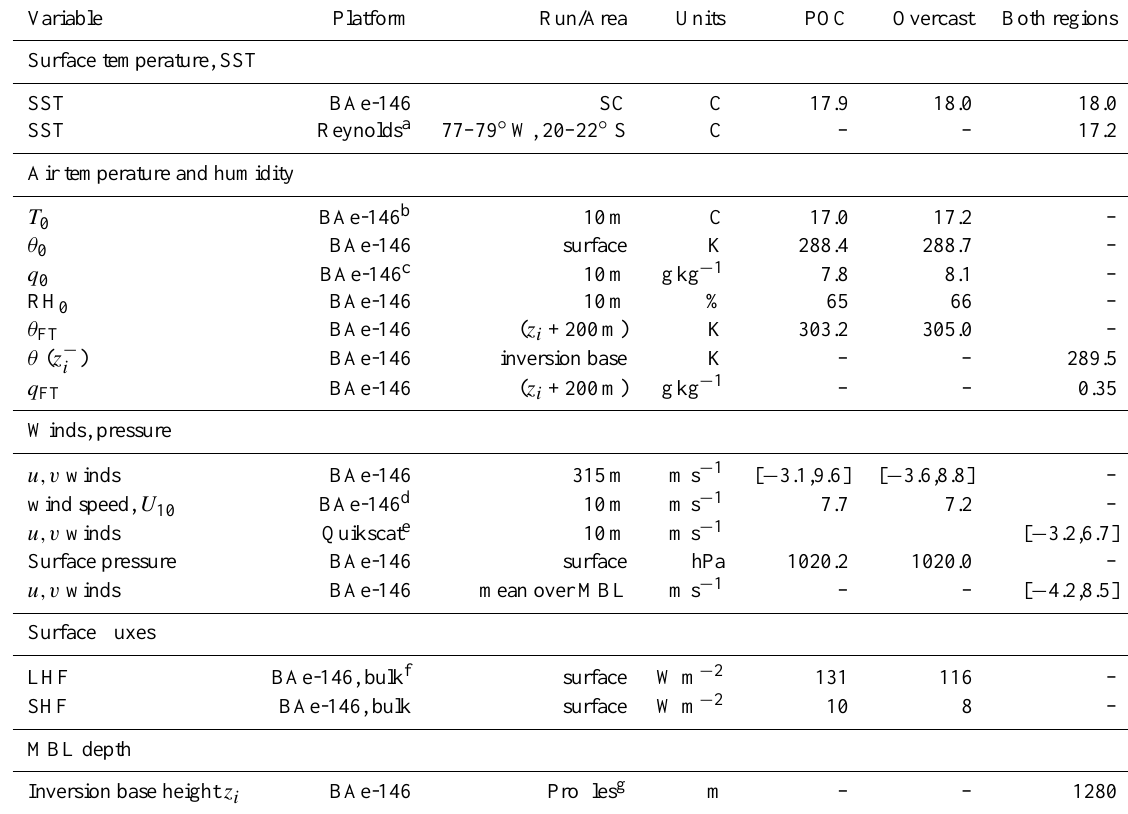
Table 3. Various large scale conditions during BAe-146 Flight B409. For some variables, values are given separately for POC and overcast, while for some only an average over a broader region is